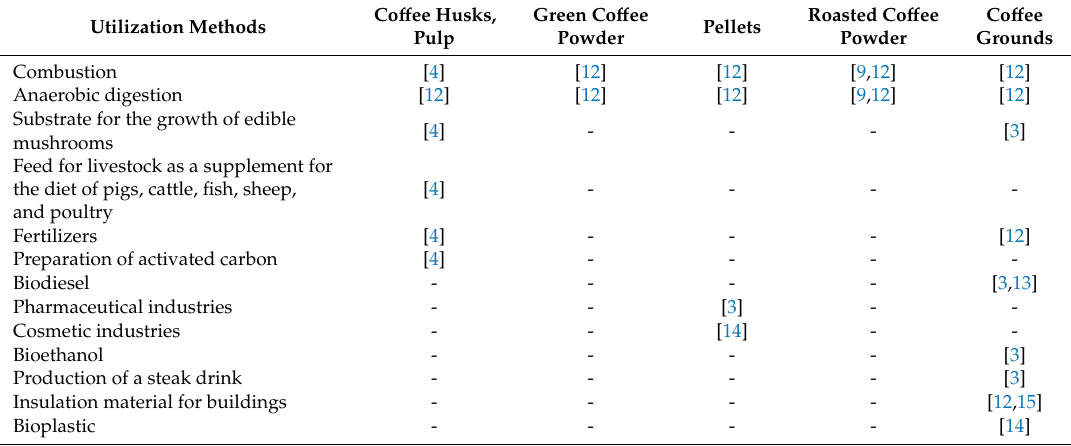
Table 1. Methods of use of co ff ee